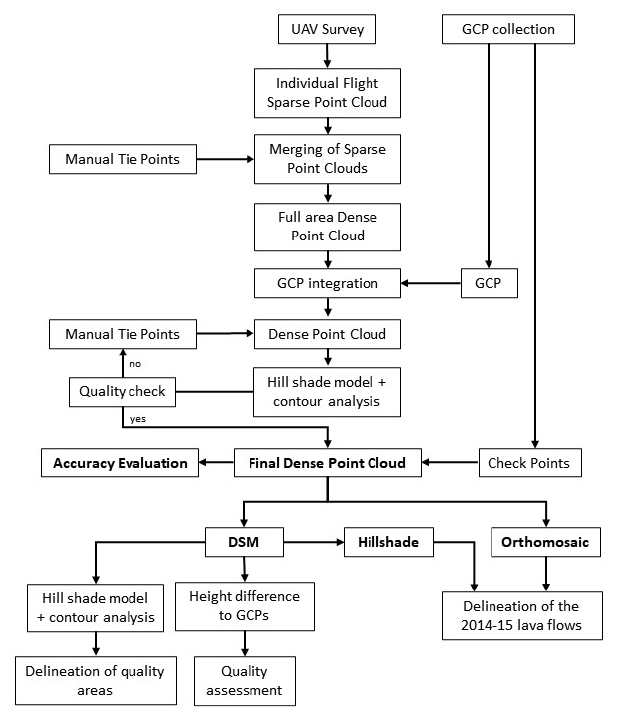
Figure 4. Workflow from the field survey to the generation of the DSMs and